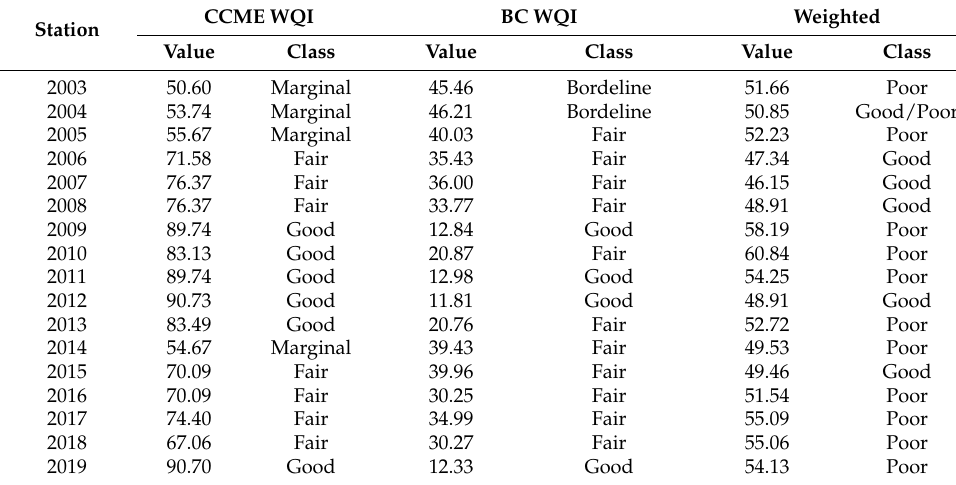
Table 4. Water quality indexes for annual series.